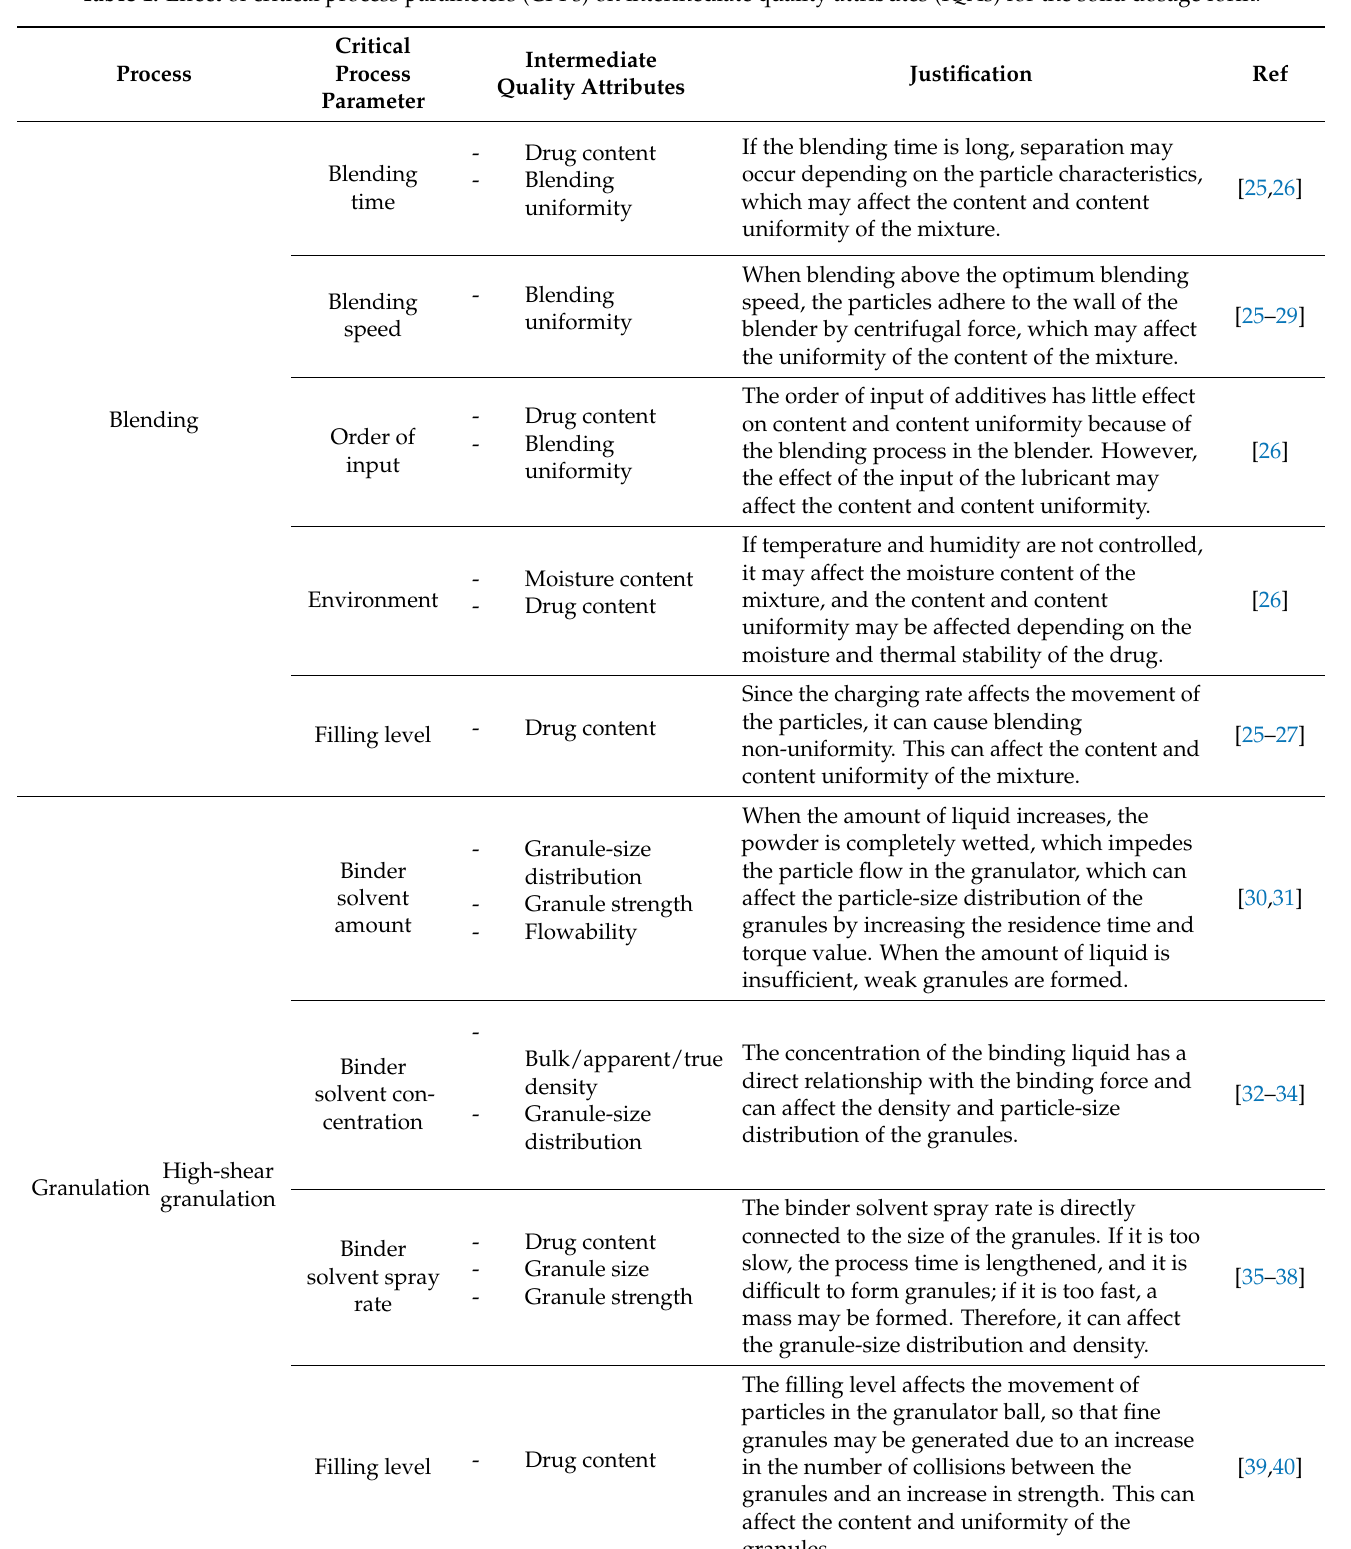
Table 1. Effect of critical process parameters (CPPs) on intermediate quality attributes (IQAs) for the solid dosage form.